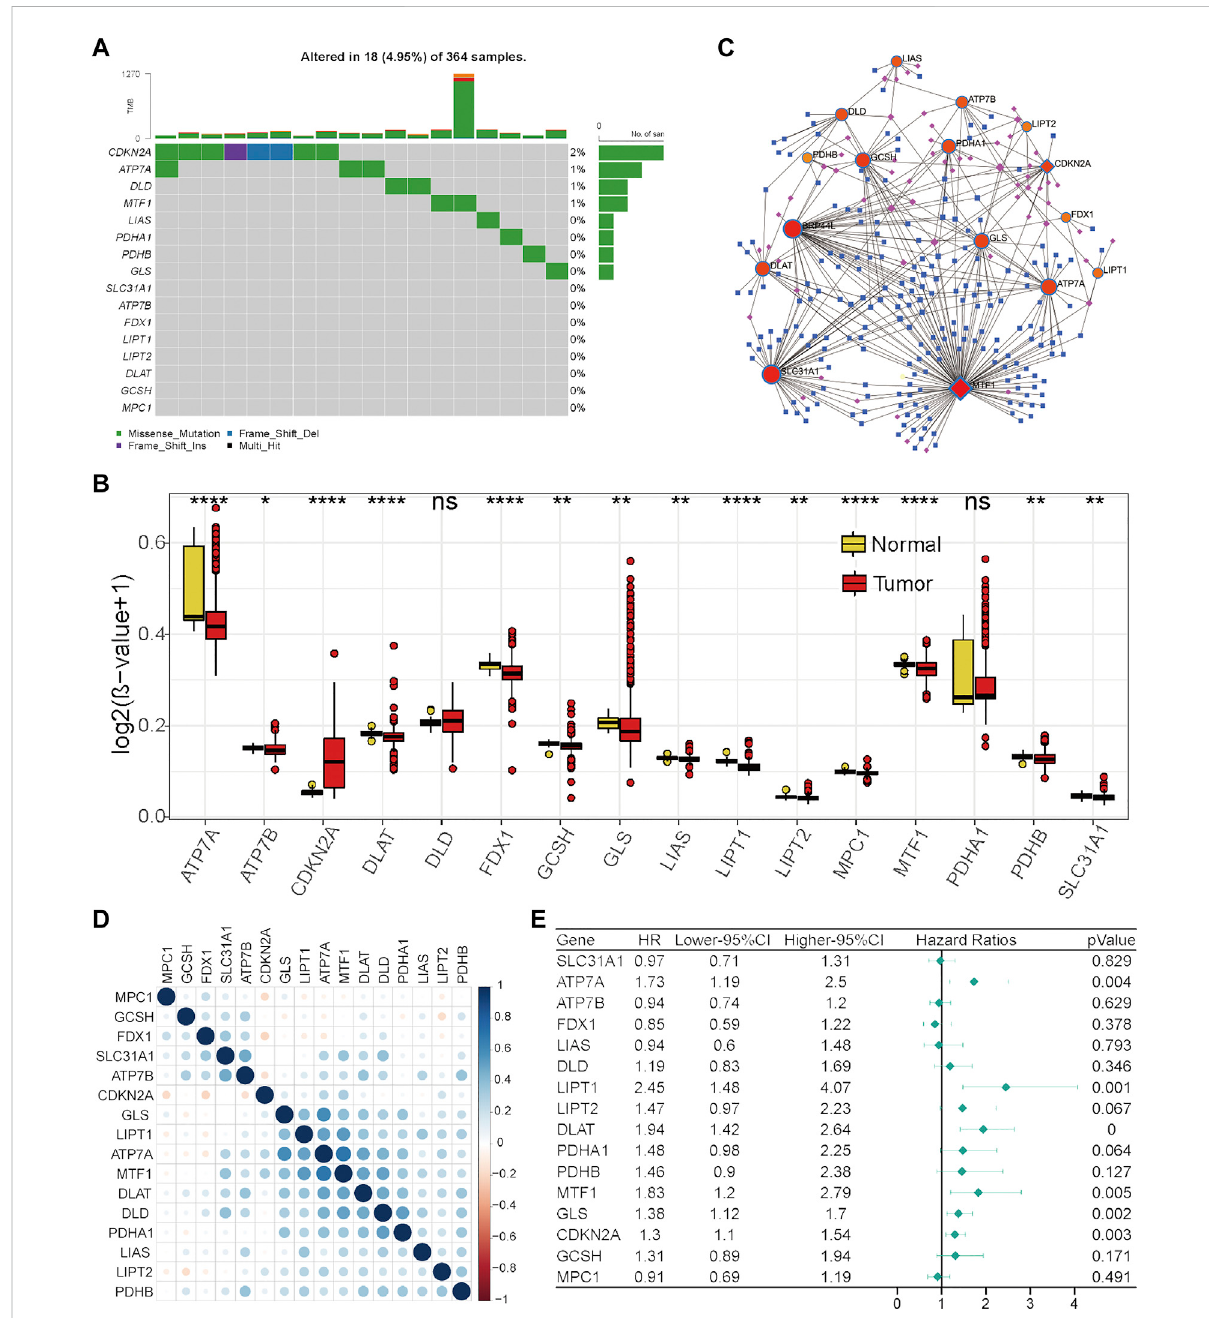
FIGURE 2 Regulation, interaction, and prognostic characteristics of the 16 cuproptosis-related genes in the TCGA-HCC cohort. (A) TMB status of the 16 cuproptosis-related genes in 364 HCC patients. (B) Differential DNA methylation levels between HCC tumor tissues and normal tissues. (C) Transcription factor and miRNA regulation network of cuproptosis-related genes. Red represents cuproptosis-related genes, pink represents transcription factors, and blue represents miRNAs. (D) Correlations among cuproptosis-related genes. (E) Forest plot results of univariate analysis of cuproptosis-related